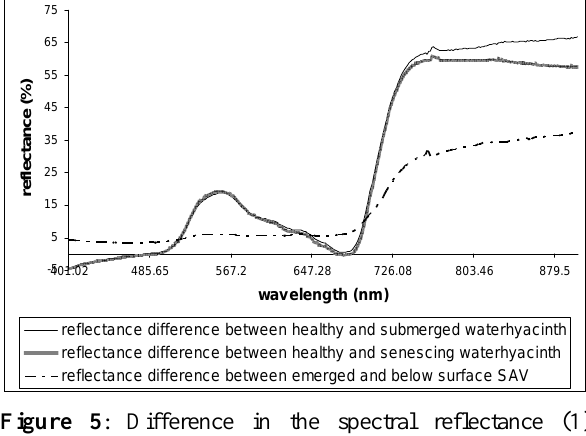
Figure 5 : Difference in the spectral reflectance (1) between floating and submerged waterhyacinth, (2) between healthy and senescing waterhyacinth, and (3) between emerged and below surface submerged aquatic vegetation (SAV). Figure 6 : Spectral reflectance of submerged aquatic